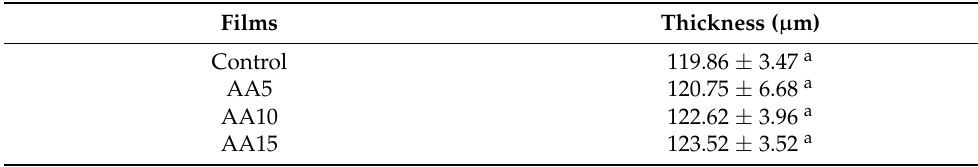
Table 2. Thickness of WPI films as a function of AA content.